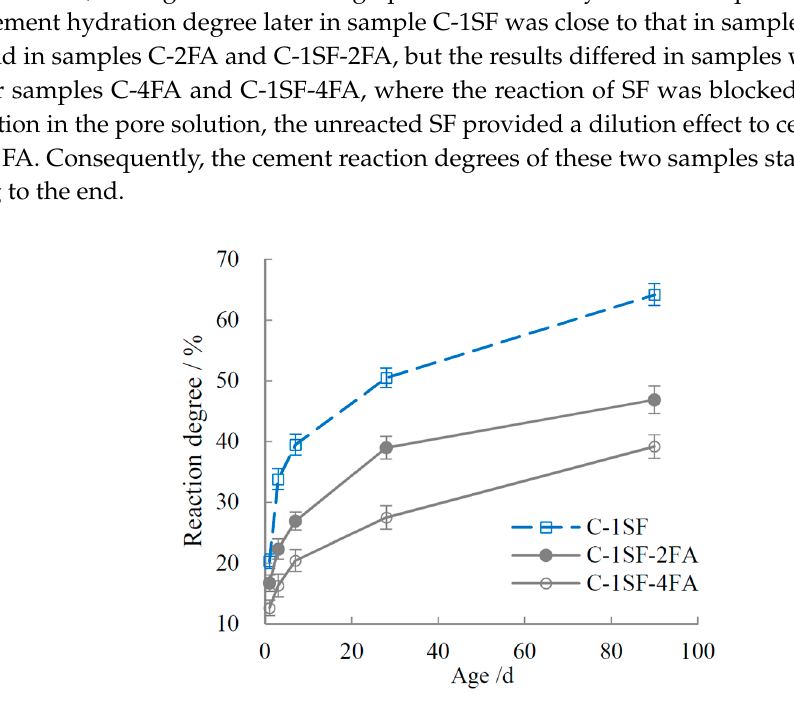
Figure 3. Reaction degree of SF.